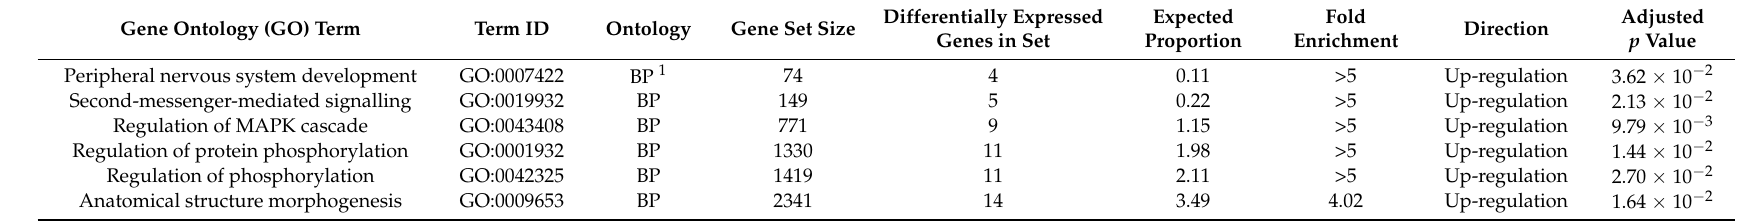
Table 3. Enriched Gene Ontologies terms for the 32 genes differentially expressed in synovial tissue of patients with contrast pain phenotypes. Gene Ontology (GO) Term